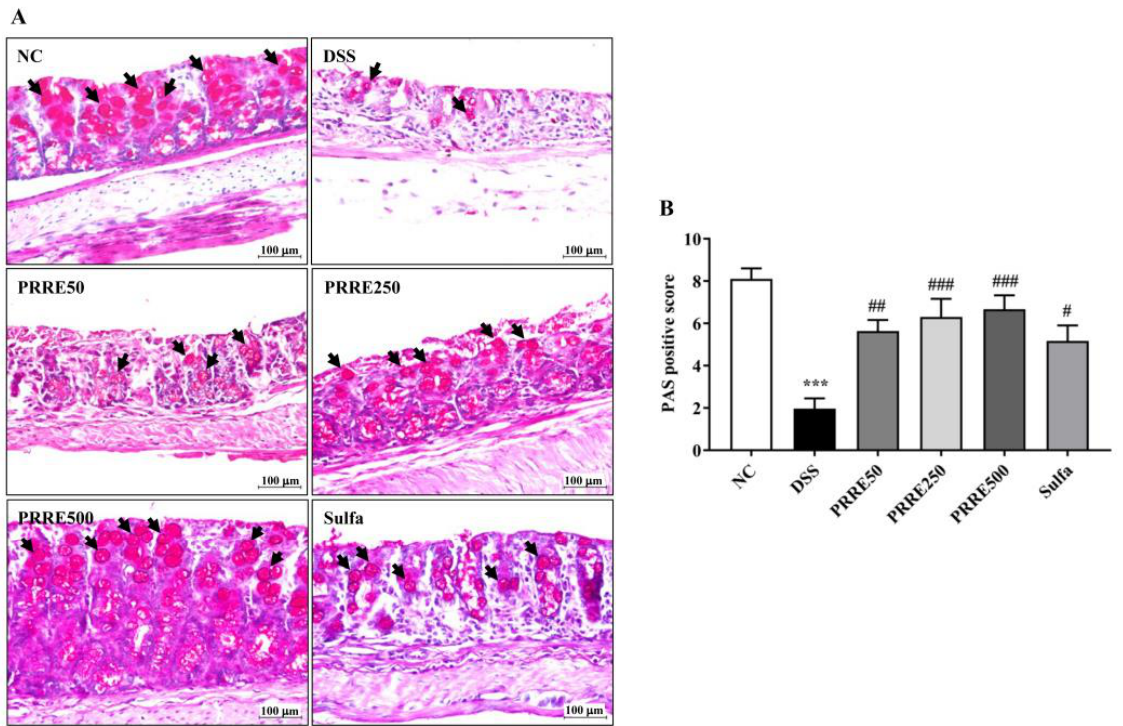
Figure 6. The effects of PRRE on mucin-secreting goblet cells in DSS-induced colitis. Representative picture of PAS staining in the colon tissue ( × 400 magnification, scale bar = 100 µ m) ( A ). Black arrows indicate the mucin-secreting goblet cells and PAS staining scores ( B ). *** p < 0.001 vs. NC group, # p < 0.05, ## p < 0.01 and ### p < 0.001 vs. DSS group. PAS = Periodic acid–Schiff, NC = normal control mice treated with the vehicle, DSS = mice treated with DSS alone, PRRE50 = DSS mice treated with PRRE at 50 mg/kg/day, PRRE250 = DSS mice treated with PRRE at 250 mg/kg/day, PRRE500 = DSS mice treated with PRRE at 500 mg/kg/day and sulfa = DSS mice treated with sulfasalazine at 50 mg/kg/day.